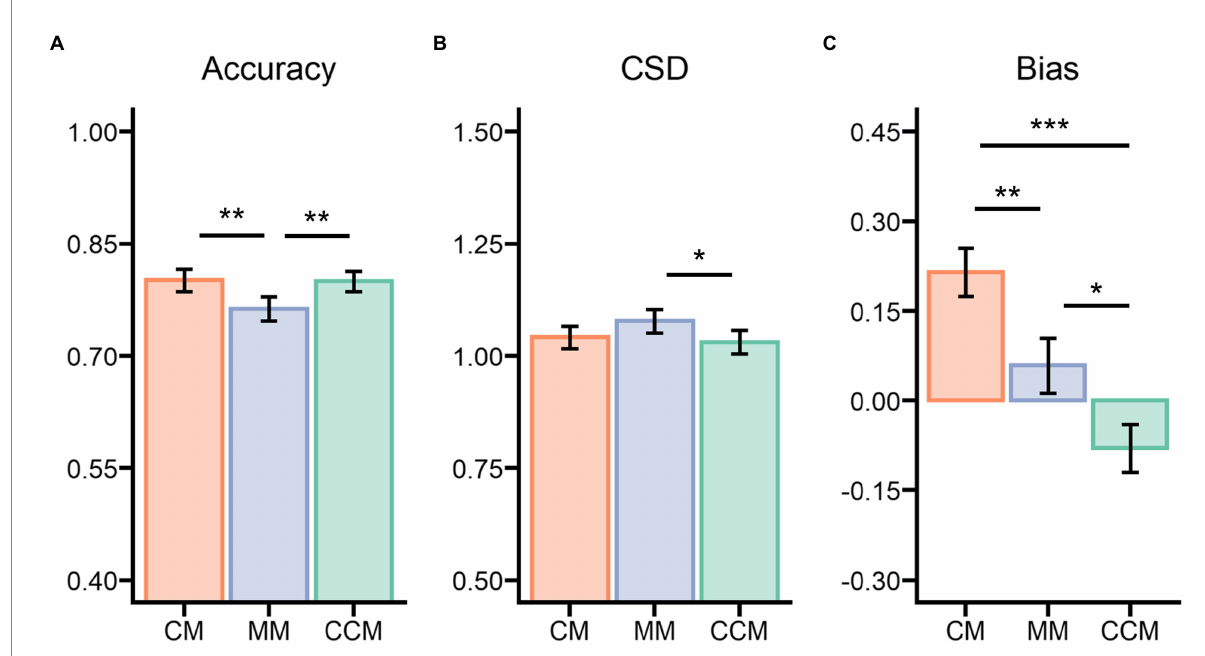
FIGURE 3 Results of Experiment 1 for the three matching conditions on (A) VWM accuracy, (B) the ensemble circular standard deviation (CSD) of the mean identity estimations, and (C) the ensemble bias parameter of the mean identity estimations. CM, clockwise matching condition; MM, mismatching condition or control condition; CCM, counterclockwise condition. * p < 0.05, ** p < 0.01, *** p <